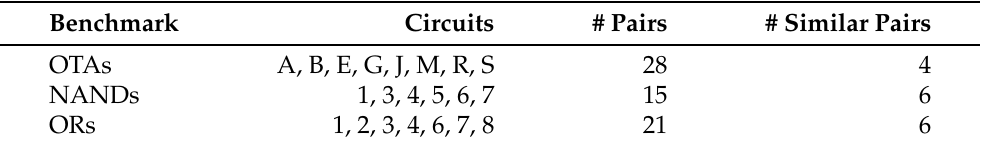
Table 1. Benchmarks used for tuning the parameters of the proposed algorithm. The symbols in column “Circuits” correspond to layouts in Figures A1 and A2 in Appendix